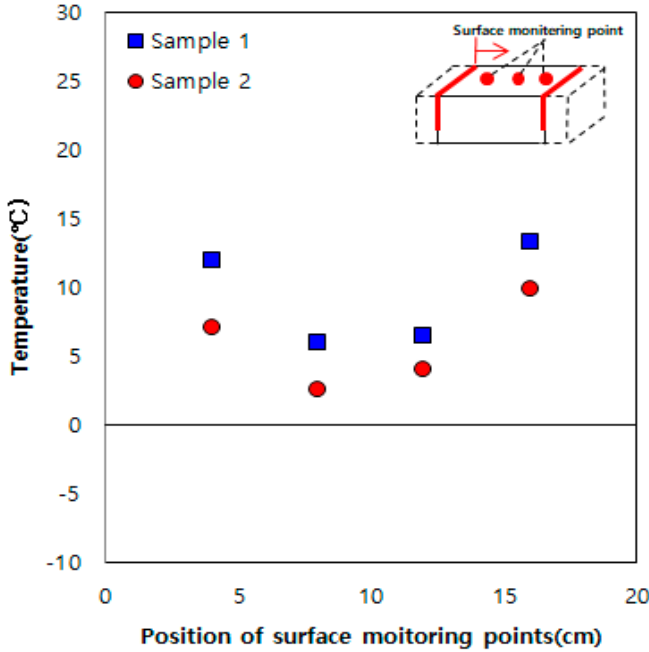
Figure 5. Results obtained using two heating elements spaced at 20 cm.